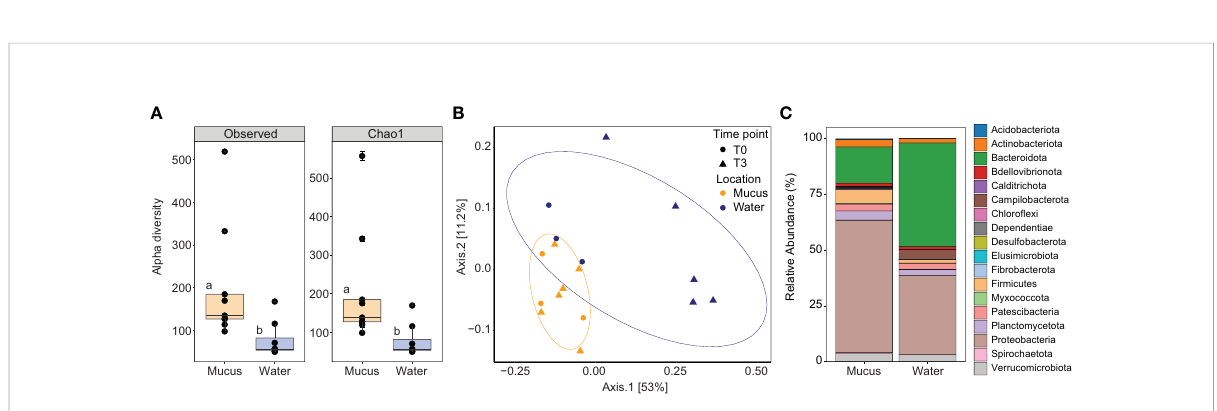
FIGURE 3 (A) Alpha diversity indices including the number of observed ASVs and species richness (Chao1) for the mucus (orange boxes), and seawater (blue boxes) samples. Data was rare fi ed to the smallest sample size depth of 5,099. Letters indicate post-hoc groupings. (B) Principal coordinate analysis (PCoA) based on weighted unifrac distance of the 16S rRNA gene amplicon sequences for the mucus (orange symbols) and seawater (dark blue symbols) at timepoint T0 (circle symbols) and T3 (triangle symbols). Ellipses show 80% con fi dence intervals. (C) Relative abundance of bacterial taxa plotted at the phylum level for the mucus and seawater samples, showing total relative abundance of each phylum >1%.